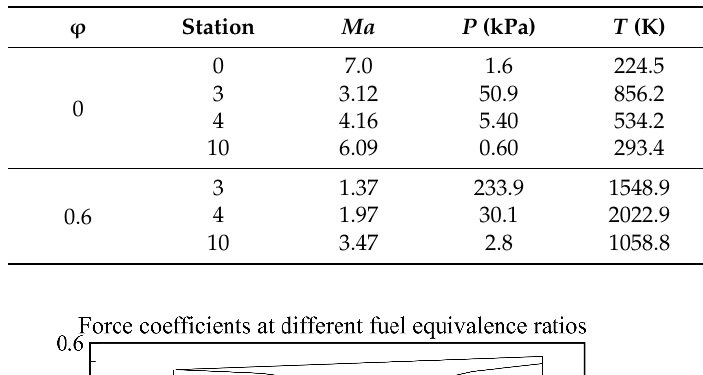
Table 3. Station flow properties at design points.